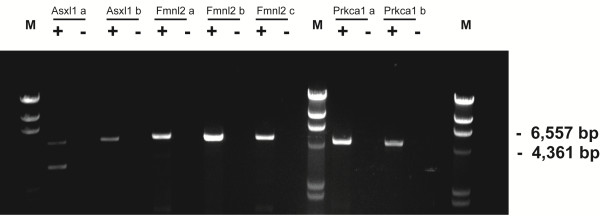
Detection of long transcripts in intronic regions using RT-PCR. Reactions were done with (“+”) and without (“-”) reverse transcriptase. The size range where the expected PCR products should fall is shown on the right. M- size standard. See text, Figures
1 &5 and Methods for more details.